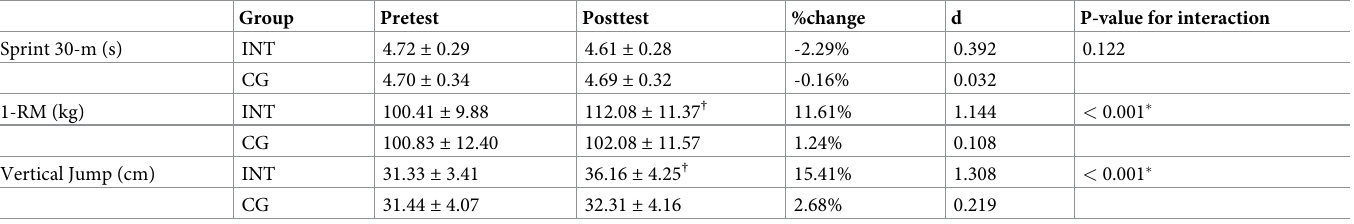
Table 2. Pretest and posttest results for physical performance following 8 weeks of intervention in INT group (INT, n = 12) and the control group (CG, n = 12).